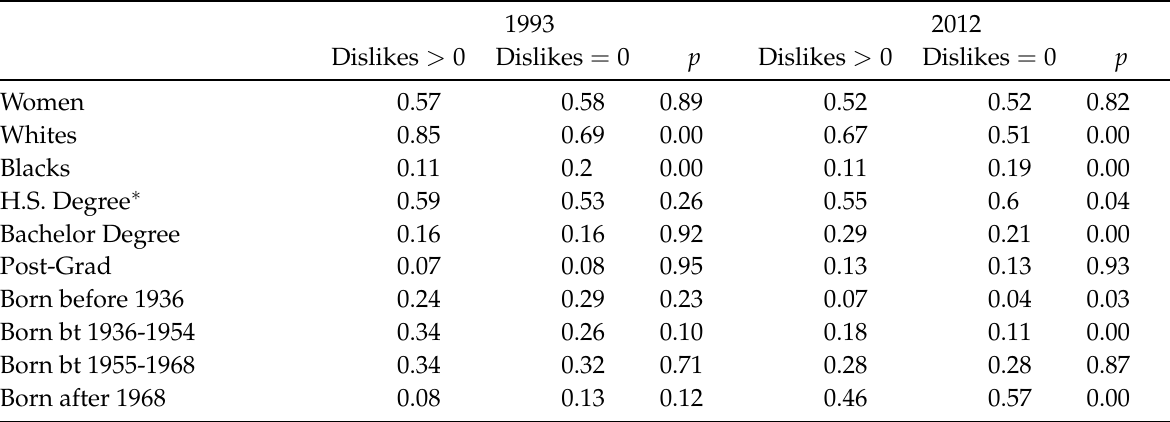
Table 1: Two sided t -test for differences in the probability of expressing no dislikes for binary predictors on gender, race, education, and